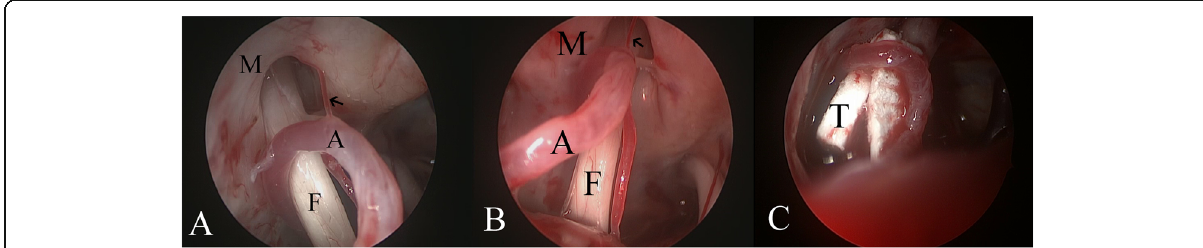
Fig. 4 ( a – c ) Endoscopic view showing AICA compressing the facial nerve (left side). M., Meatus. A., AICA. F., Facial nerve. T., Teflon. Arrow